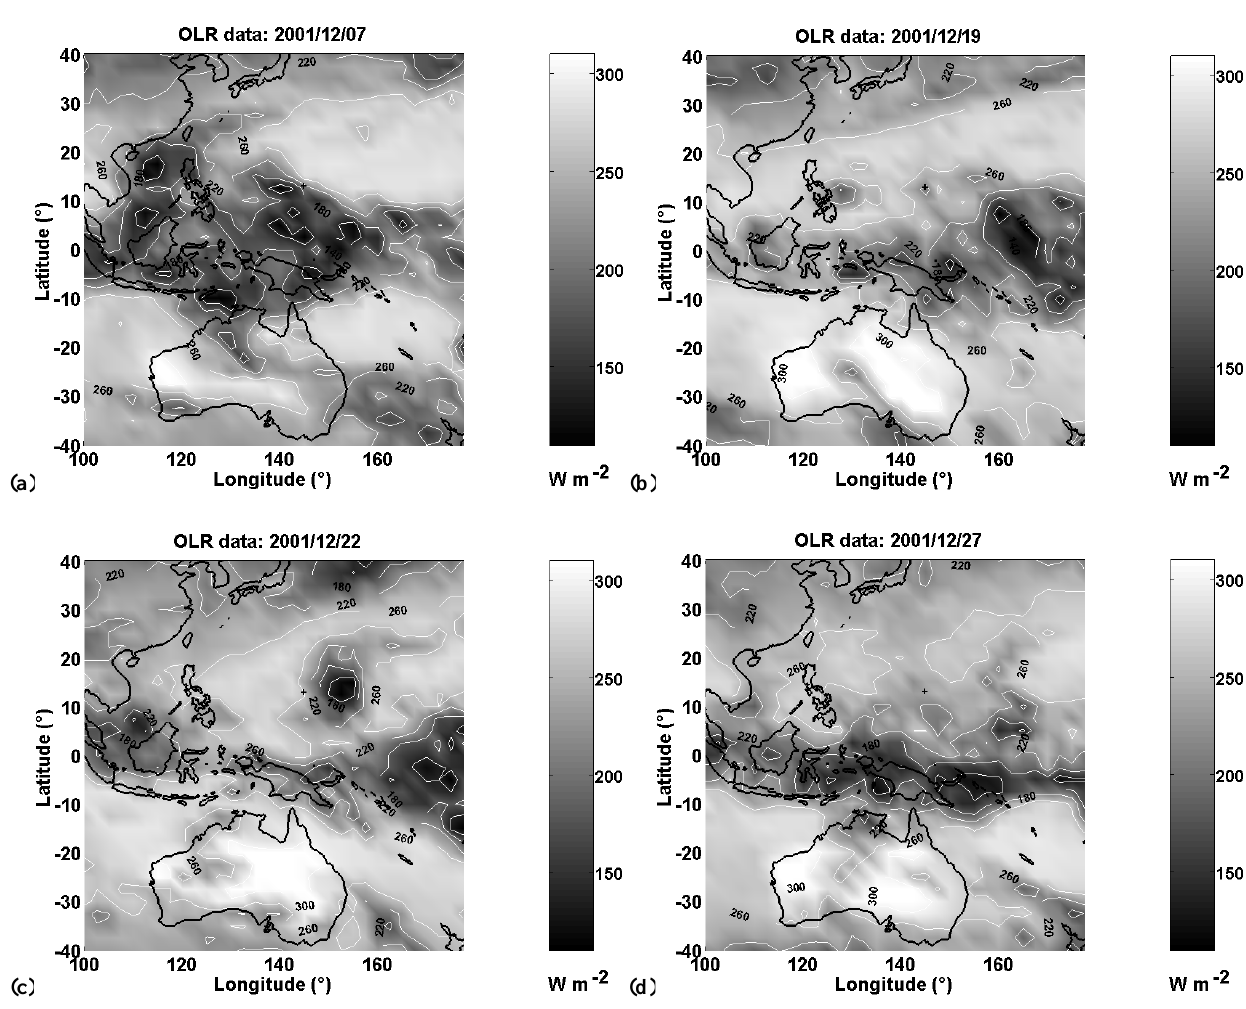
Fig. 9. Daily maps of 2.5 ◦ –2.5 ◦ gridded NOAA Interpolated Outgoing Longwave Radiation (OLR) at longitudes between 100 ◦ E and 177.5 ◦ E and at latitudes between 40 ◦ S and 40 ◦ N on (a) 7 December, (b) 19 December, (c) 22 December and (d) 27 December 2001.